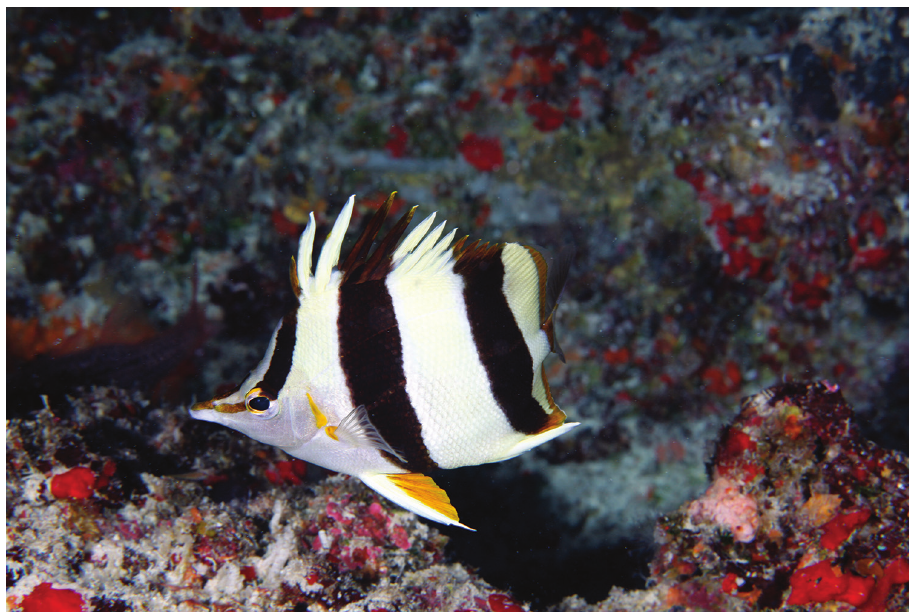
Figure 3. Prognathodes basabei at a depth of approximately 55 m off Pearl and Hermes Atoll, Northwest- ern Hawaiian Islands. Photo by G.